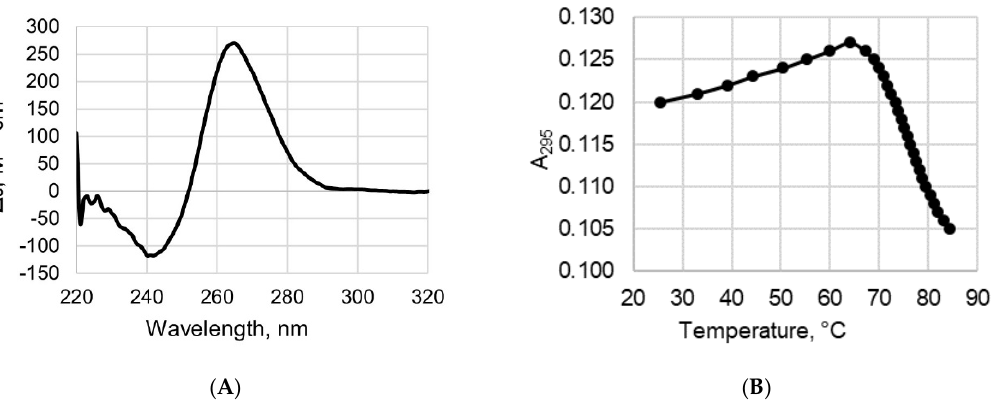
Figure 3. Analysis of the G4 structure formed by the oligonucleotide 19G4 by spectroscopic meth- ods. ( A ) CD spectrum recorded in buffer A containing 100 mM KCl at 25 °C (~2 µM oligonucleotide concentration). ( B ) Thermal melting curve measured at 295 nm in buffer B containing 2.5 mM KCl at ~4 µM oligonucleotide strand concentration.